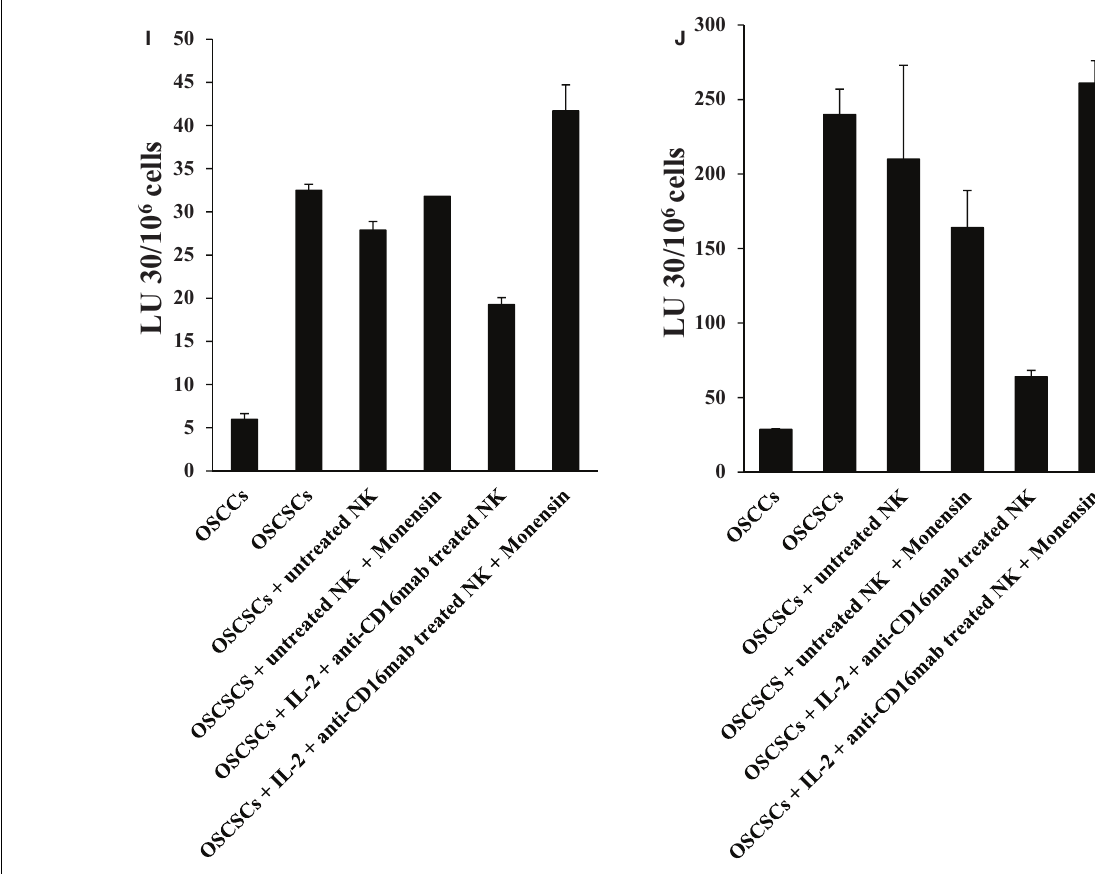
of the tumor cells × 100.The surface expression of CD54, CD44, and MHC class I on untreated and fixed NK-treated OSCSCs as described above were assessed after PE-conjugated antibody staining followed by flow cytometric analysis. Isotype control antibodies were used as controls.The numbers on the right hand corner are the percentages and the mean channel fluorescence intensities for each histogram (L) . At the end of the incubation of OSCSCs with fixed NK cells, the media containing the fixed NK samples were removed from OSCSCs and the viability of the cells were assessed using propidium iodide staining followed by flow cytometric analysis (M) . One of minimum three representative experiments is shown in each of (A–M)